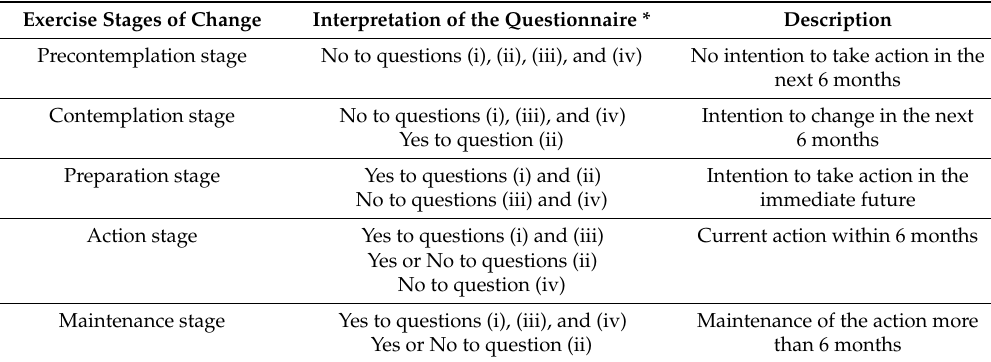
Table 2. Interpretation and description of exercise stages of